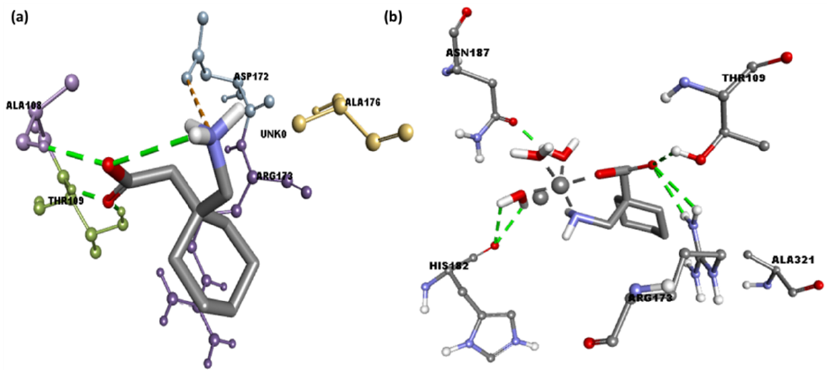
Figure 7. The 3D representation of the interactions for serotonin (PDB ID: 6BQH) docked with ( a ) the Gpn drug and ( b ) metal complex [Cu(II)–(Gpn)].